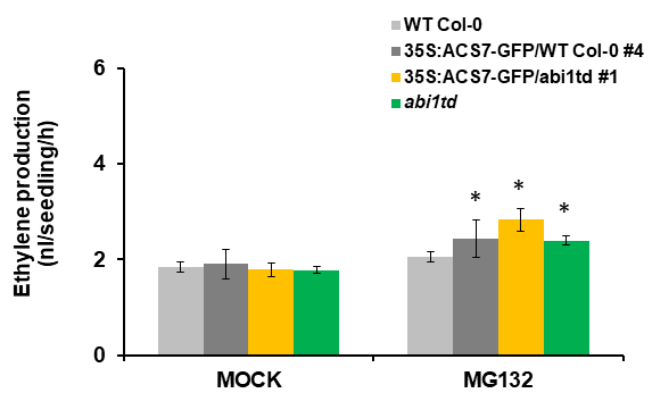
Figure 7. MG132 increases ethylene production in transgenic plants expressing 35S:ACS7–GFP vector construct. Two-week old seedlings were treated with MG132 (or equivalent control) in GC vials, and ethylene in the headspace was measured. Experiments were performed in triplicate, with consistent results (n = 5–10 replicates for each treatment). Error bars show standard deviation. Asterisks indicate a statistically significant difference at p < 0.05.